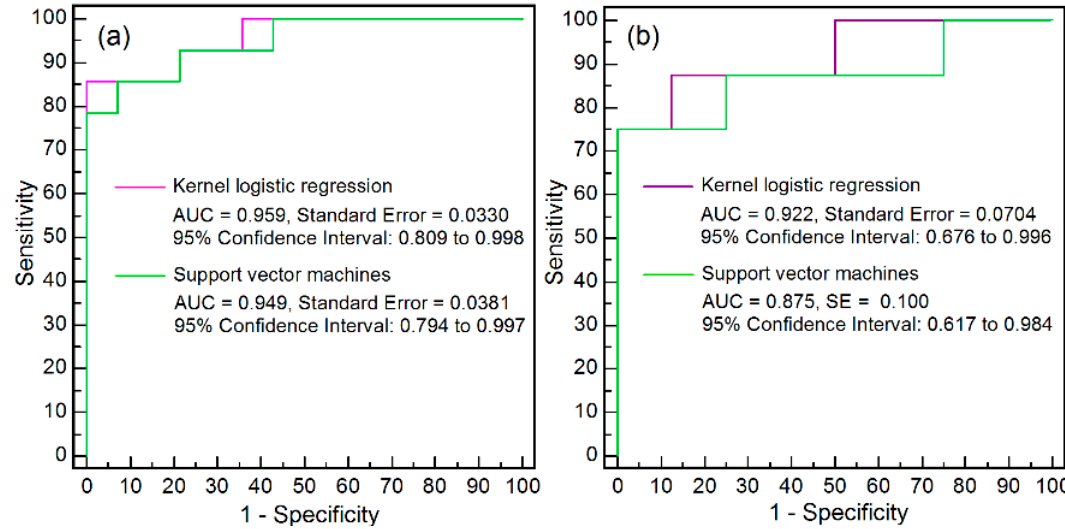
Figure 3. The Receiver Operating Characteristic (ROC) curve and area under the ROC curve (AUC) for the Kernel logistic regression model and the support vector machine model on ( a ) the training dataset and ( b ) validation dataset.